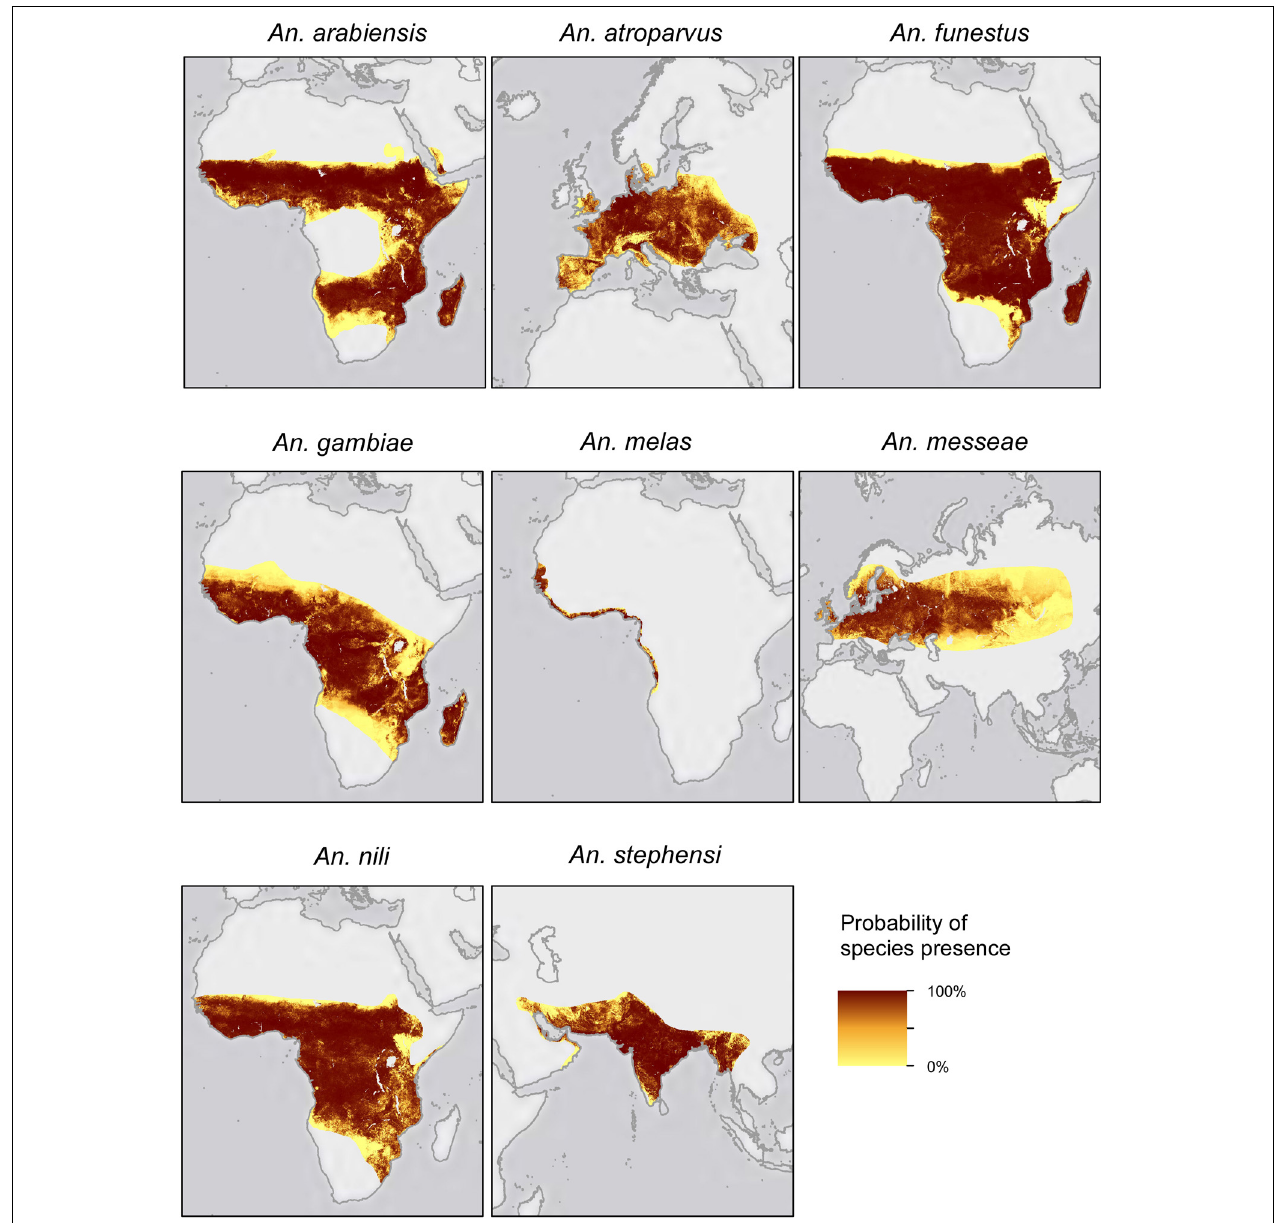
FIGURE 1 | Geographical distribution of the eight Anopheles species reviewed in this work (modified from Sinka et al.,